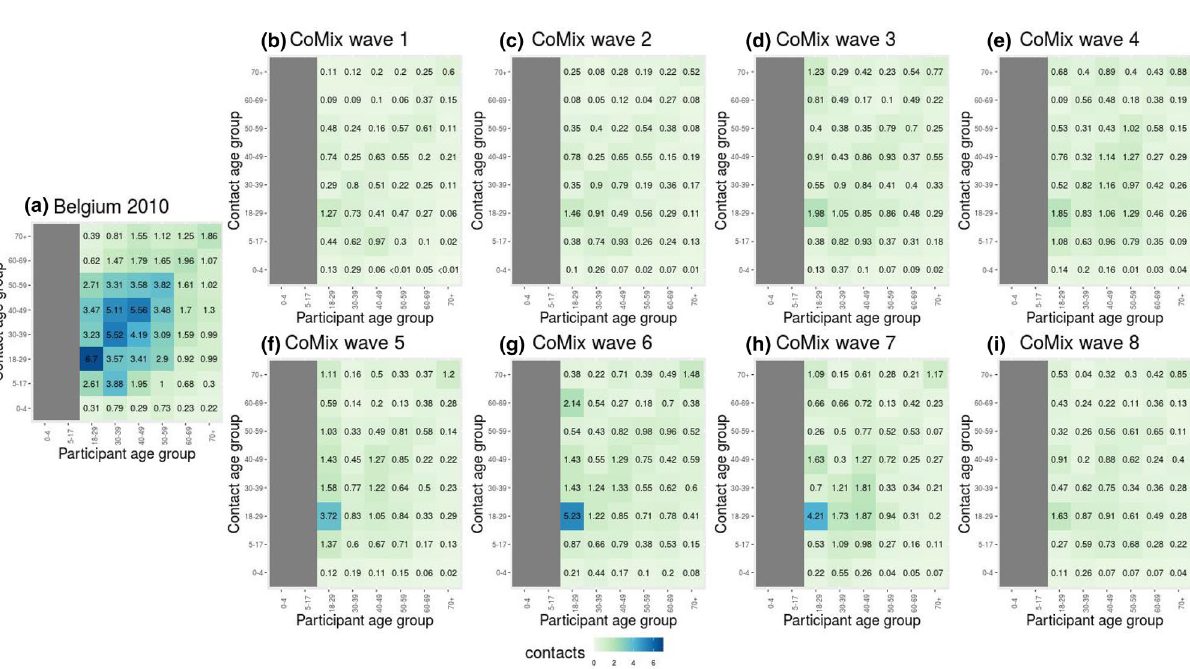
Figs. S5 and S6) than contacts outside the household. With respect to the pre-pandemic period, in all CoMix survey waves a smaller fraction of contacts involving skin-to-skin touching was observed. Participant gender, household size and day of the week do not show a significant relation with the average number of contacts.